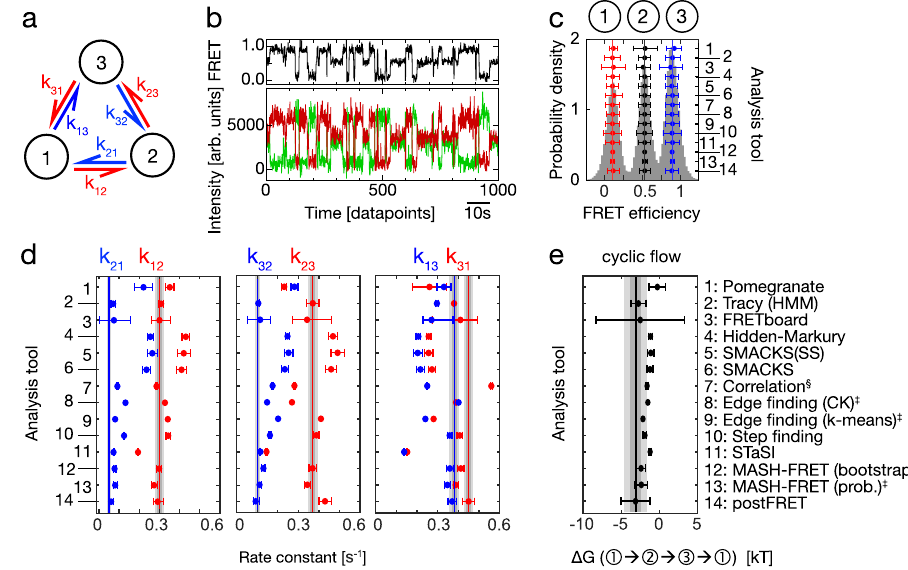
Fig. 3 | Quantitative analysis of a non-equilibrium steady-state system. a An illustration of the simulated three-state model with a counter-clockwise net fl ow. States (circles) are connected by forward and reverse rate constants as speci fi ed. b AsimulatedsmFRETtracewithdonorandacceptor fl uorescenceintensity(green, red) and FRET ef fi ciency (FRET, black), representative for the dataset used in ( c , d , e ): n(traces)=150, n(datapoints)=82,594, sampling rate=10Hz, time per datapoint=100ms. c SmFRET histogram overlaid with the inferred FRET ef fi - ciencies (right axis, numbers as in e ) and assigned states on top. Sample size as in ( b ). The error bars represent standard deviations. d Inferred rate constants are shown in red and blue as speci fi ed. Vertical lines indicate the GT. The intrinsic uncertainty of the dataset is represented by dark gray (1 σ ) and light gray (2 σ )